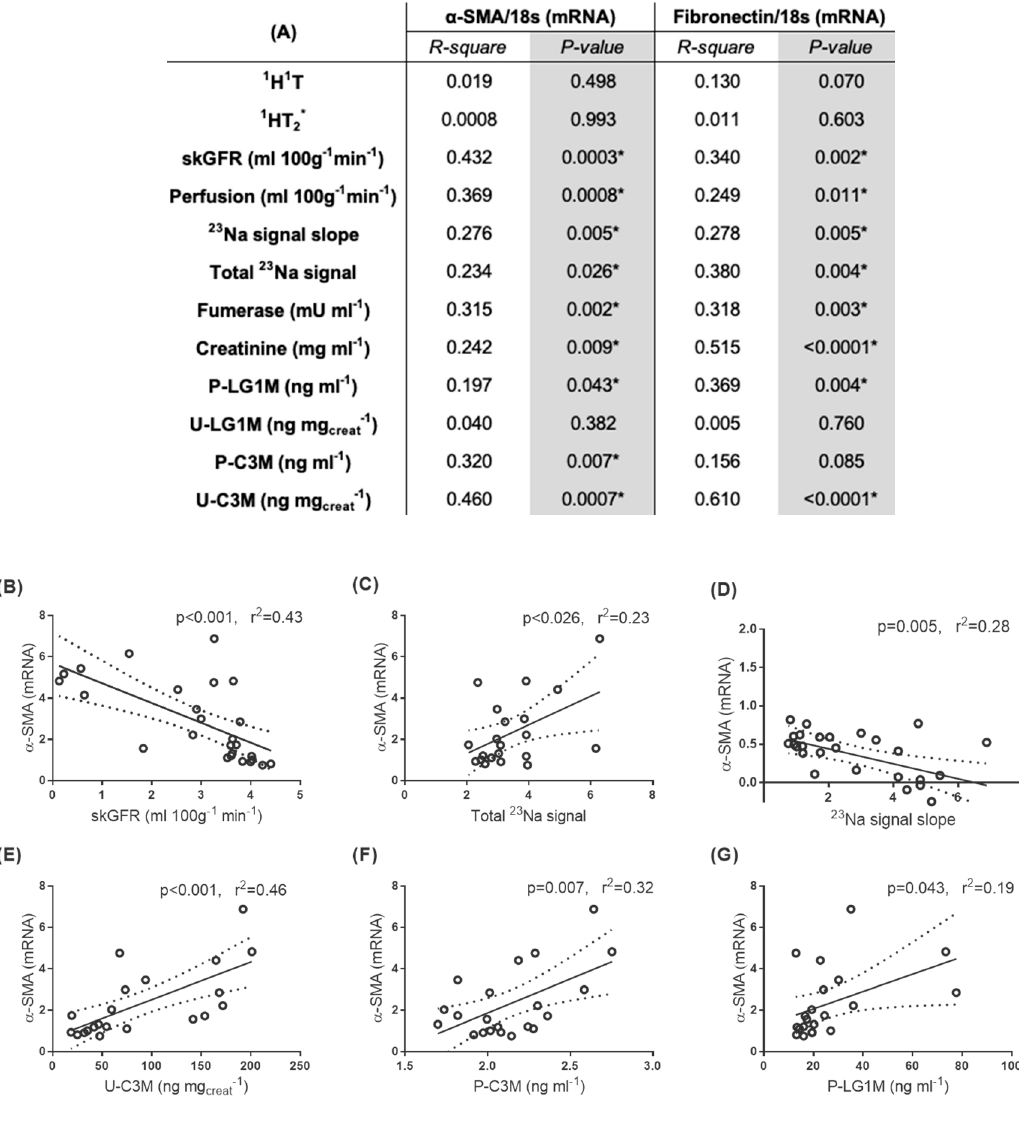
Figure 6. Correlations of α SMA and fibronectin with MRI data and noninvasive extracellular markers as well as markers of kidney damage: ( A ) a table with Person’s correlations values between tissue fibrosis markers ( α -SMA and fibronectin) and utilized MRI sequences, kidney damage markers, and the noninvasive extracellular markers and linear correlations graphs ( B ) between α -SMA mRNA and single-kidney glomerular filtration rate (skGFR), ( C ) between α -SMA mRNA and total 23 Na signal, ( D ) between α -SMA mRNA and 23 Na signal slope, ( E ) between α -SMA mRNA and urinary type III collagen marker (U-C3M), ( F ) between α -SMA mRNA and plasma C3M (P-C3M), and ( G ) between α -SMA mRNA and plasma LG1M (P-LG1M). * p < 0.05 was considered